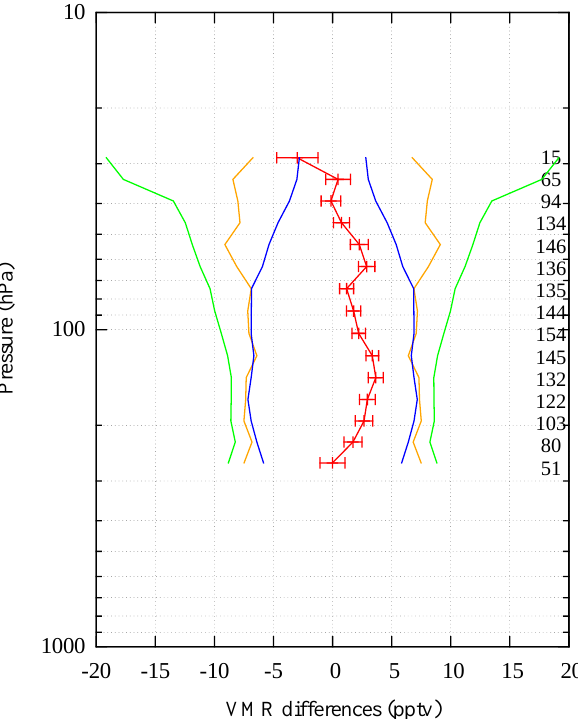
Figure 7. Average difference profile between the co-located MI- PAS and ACE-FTS measurements (red) with standard deviation of the mean (red error bars). The standard deviation of the difference (orange-red), the total random error (green), the total systematic er- ror of the difference (blue) are also reported. The number of co- located pairs for each pressure level is reported on the right side of the